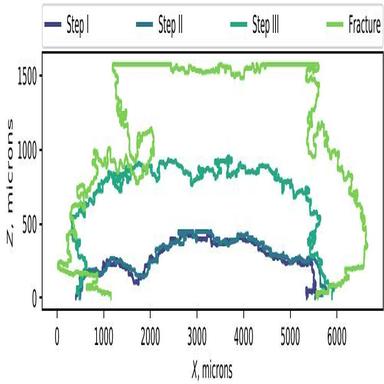
Contours of the LME inner crack propagation during loading, projected in the XZ plane perpendicular to the load direction.